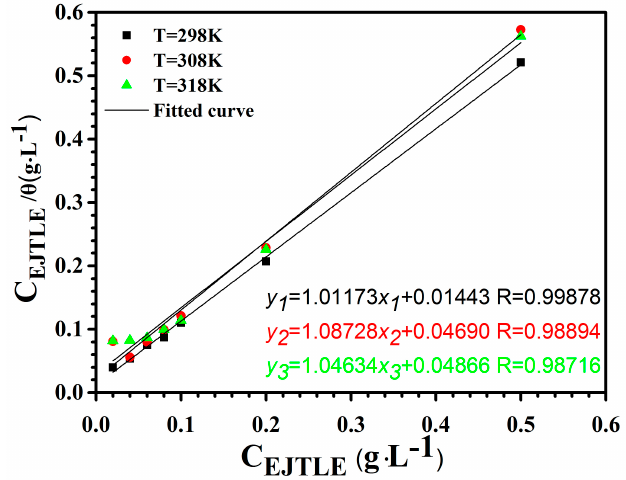
Figure 7. Langmuir adsorption isotherm of EJTLE on the C-steel surface in 1 M HCl solution at 298 K, 308 K and 318 K.